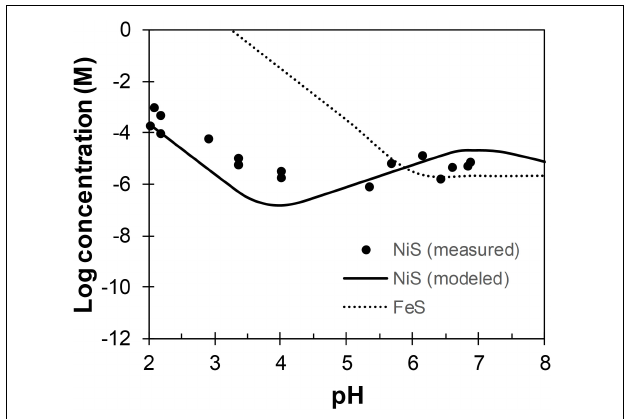
FIGURE 10 | Concentrations of Ni and Fe across pH in equilibrium with α -NiS (Wilkin and Rogers, 2010) and mackinawite (Rickard, 2006), respectively. Total sulfide concentration is assumed to be 1